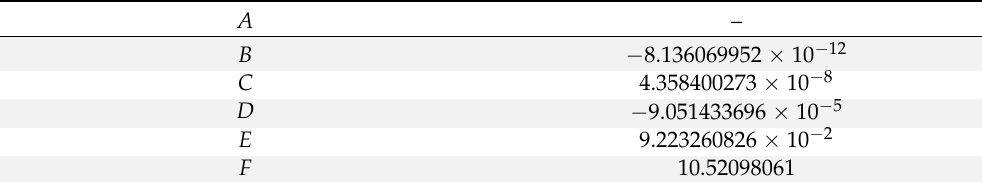
Table 2. Coefficients for Equation (1) for the temperature range 600 K to 1600 K, SiC (J/mol/K).